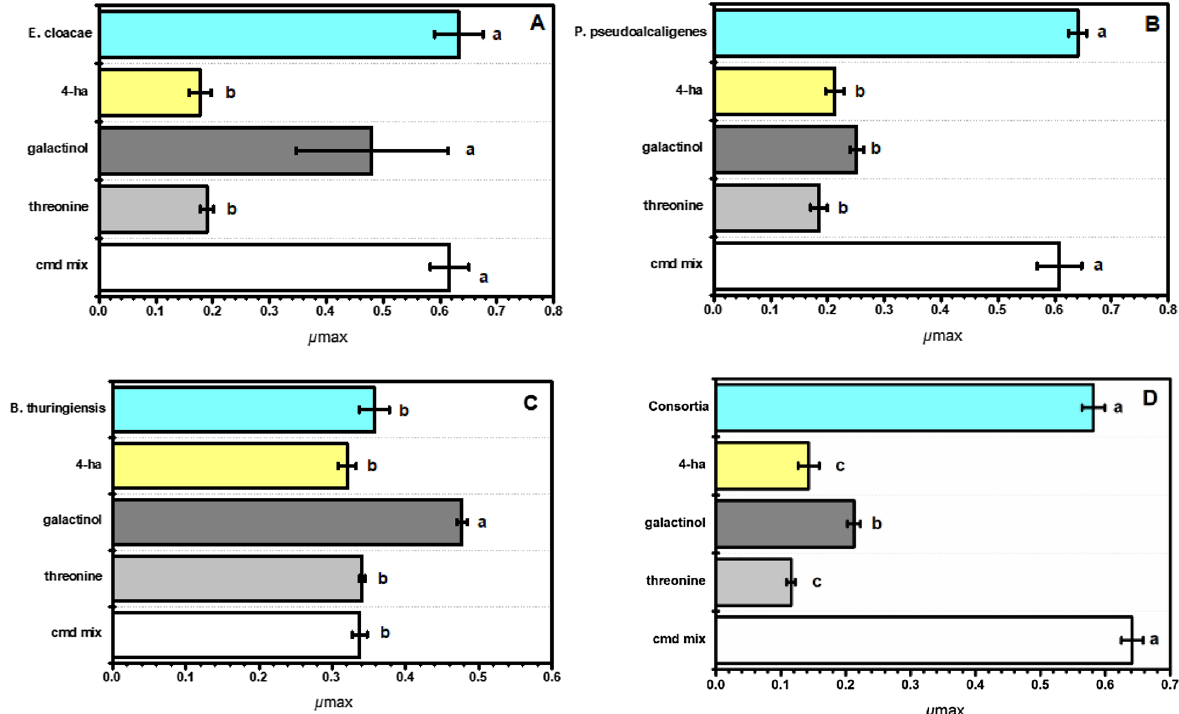
Figure 2. Maximum specific growth rate ( μ max ) of P solubilizing bacteria incubated with different root exudates in phytin organic media. Each panel corresponds to ( A ) Enterobacter cloacae , ( B ) Pseudomonas pseudoalcaligenes , ( C ) Bacillus thuringiensis , ( D ) bacterial consortium. Y-axis shows from top to bottom the control: individual bacteria or consortium in blue; 4-ha: 4-hydroxybutyric acid in yellow; galactinol in dark gray; threonine in light grey; and cmd mix: compound combination in white. A one-way ANOVA was performed to compare the effect of root exudates on bacteria. Tukey’s HSD test for multiple comparisons show significant differences. Different letters denote statistical significance among treatments ( p-value <